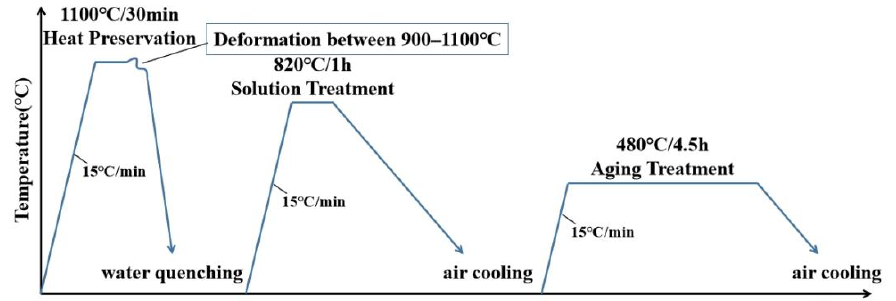
Figure 3. Schematic of the heat treatment.